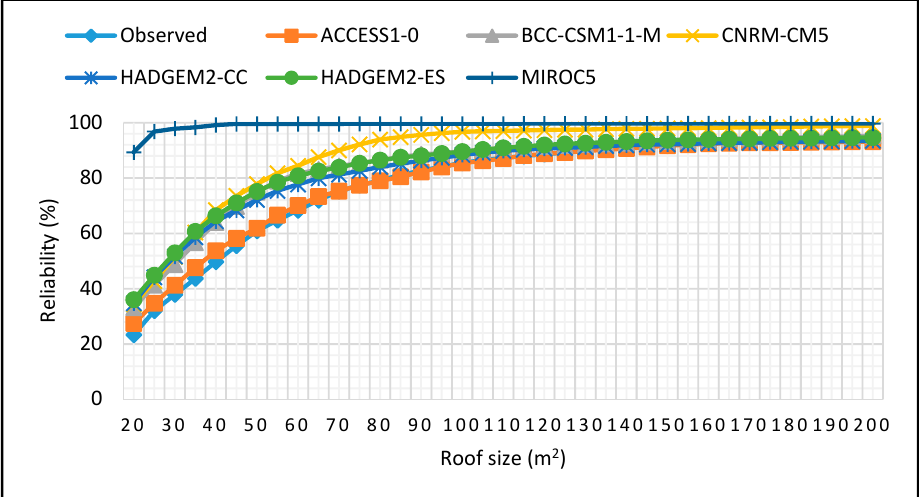
Figure 23. Reliability projections for JJA season for 5 m 3 tank size for 2060–2090 period.